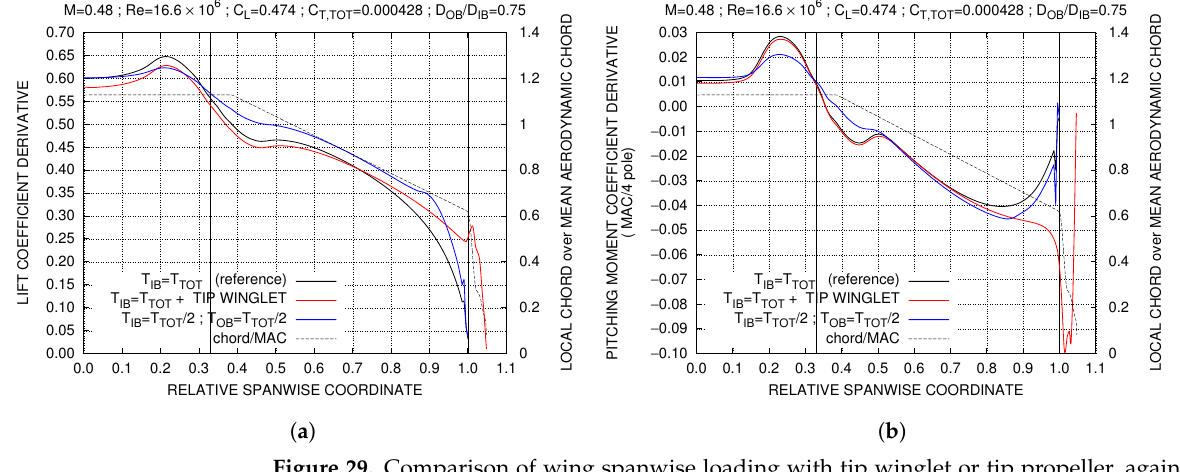
Figure 29. Comparison of wing spanwise loading with tip winglet or tip propeller, against refer- ence configuration, in cruise flight conditions: ( a ) lift coefficient derivative; ( b ) pitching moment coefficient derivative.